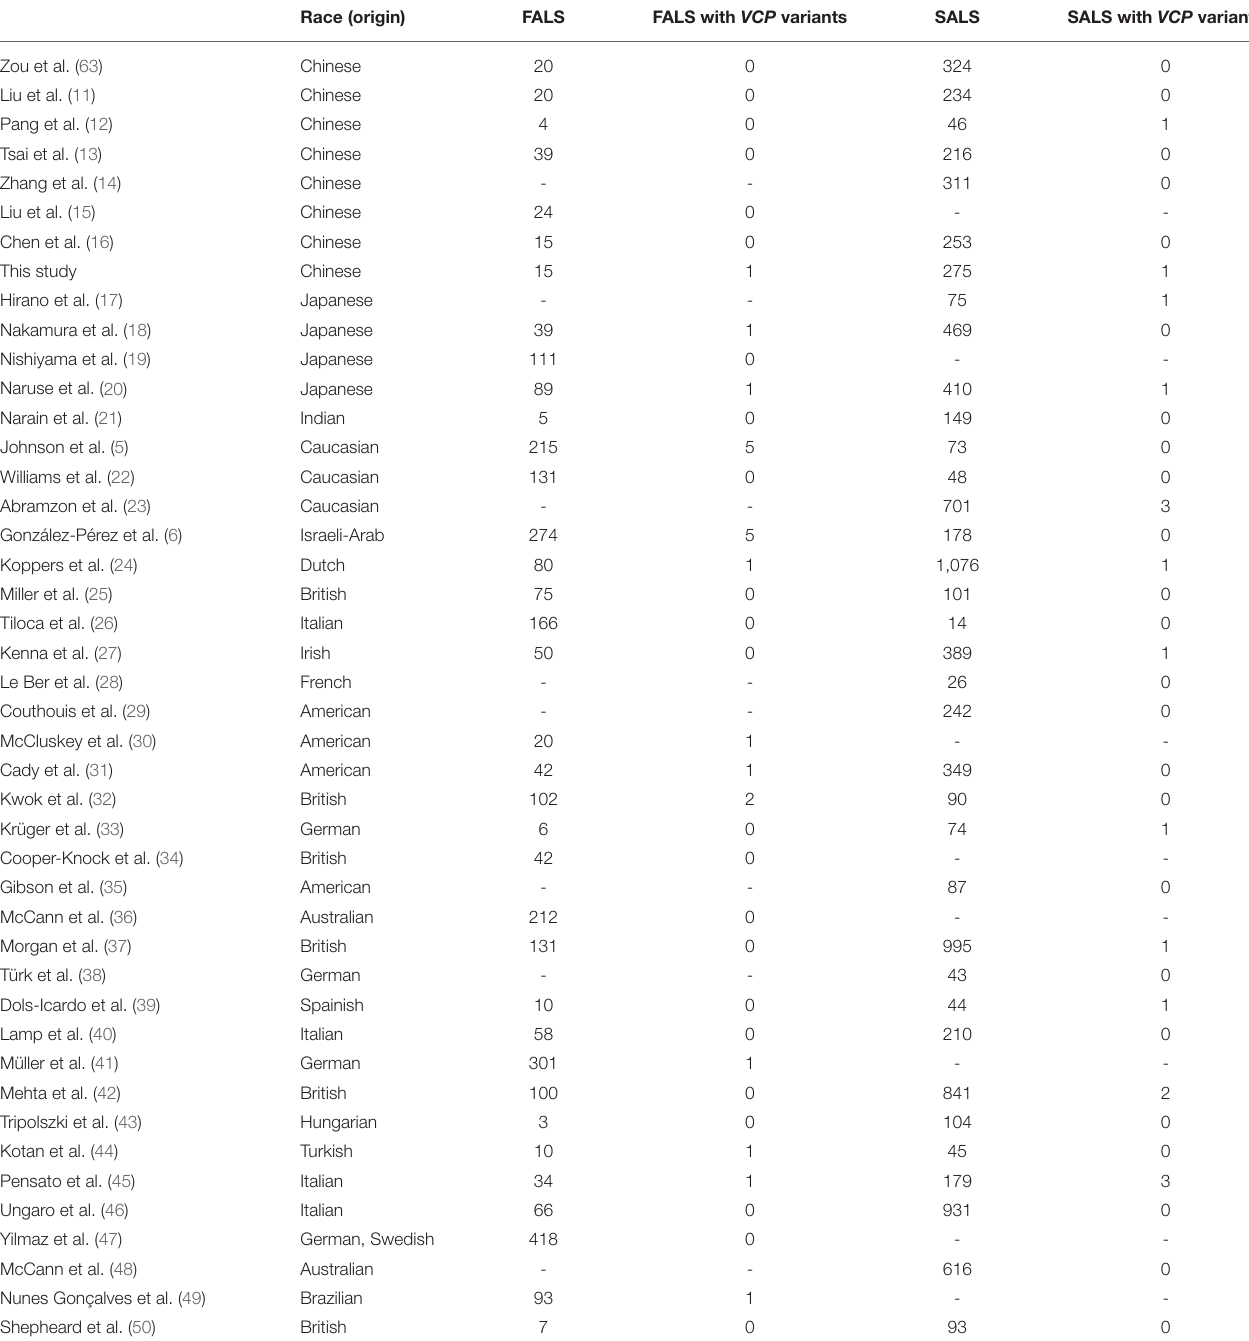
TABLE 2 | Summary of studies screened VCP variants in patients with